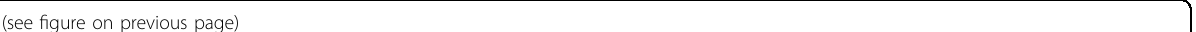
Fig. 4 MTHFD1 contributes to different cellular redox statuses and therefore chemoresistance to gemcitabine in cholangiocarcinoma. A Heat map of reductase encoded gene in each subpopulation by quantitative real-time PCR. B , C Relative expression of MTHFD1 mRNA in QBC939 and HUCCT1 respectively by quantitative real-time PCR. D HyPer-Low subpopulation of CCA cells possess a higher expression level of MTHFD1 protein. E Ratio of cellular NADPH/NADP + in each subpopulation by microplate reader. F , G MTHFD1 knockdown ef fi ciency by short interfering RNA was detected by quantitative real-time PCR. H Ratio of cellular NADPH/NADP + in Scumble-treat and siM1#1 treat HyPer-low CCA cells by microplate reader. I , J QBC939 and HyPer-Low subpopulation of CCA cells were treated with short interfering RNA of MTHFD1, or its vector or NAC. The ratio of fl uorescence was detected by fl ow-cytometric analysis. K , L HyPer-High and HyPer-Low subpopulation of CCA cells and siM1#1 HyPer-Low cells were treated with Gemcitabine or NAC at the indicated concentrations for 48 h. Cell viability was measured using CCK8. M Quanti fi cation of overall survival data from TCGA database. Each experiment was performed in triplicate. * p < 0.05; ** p < 0.01; *** p <